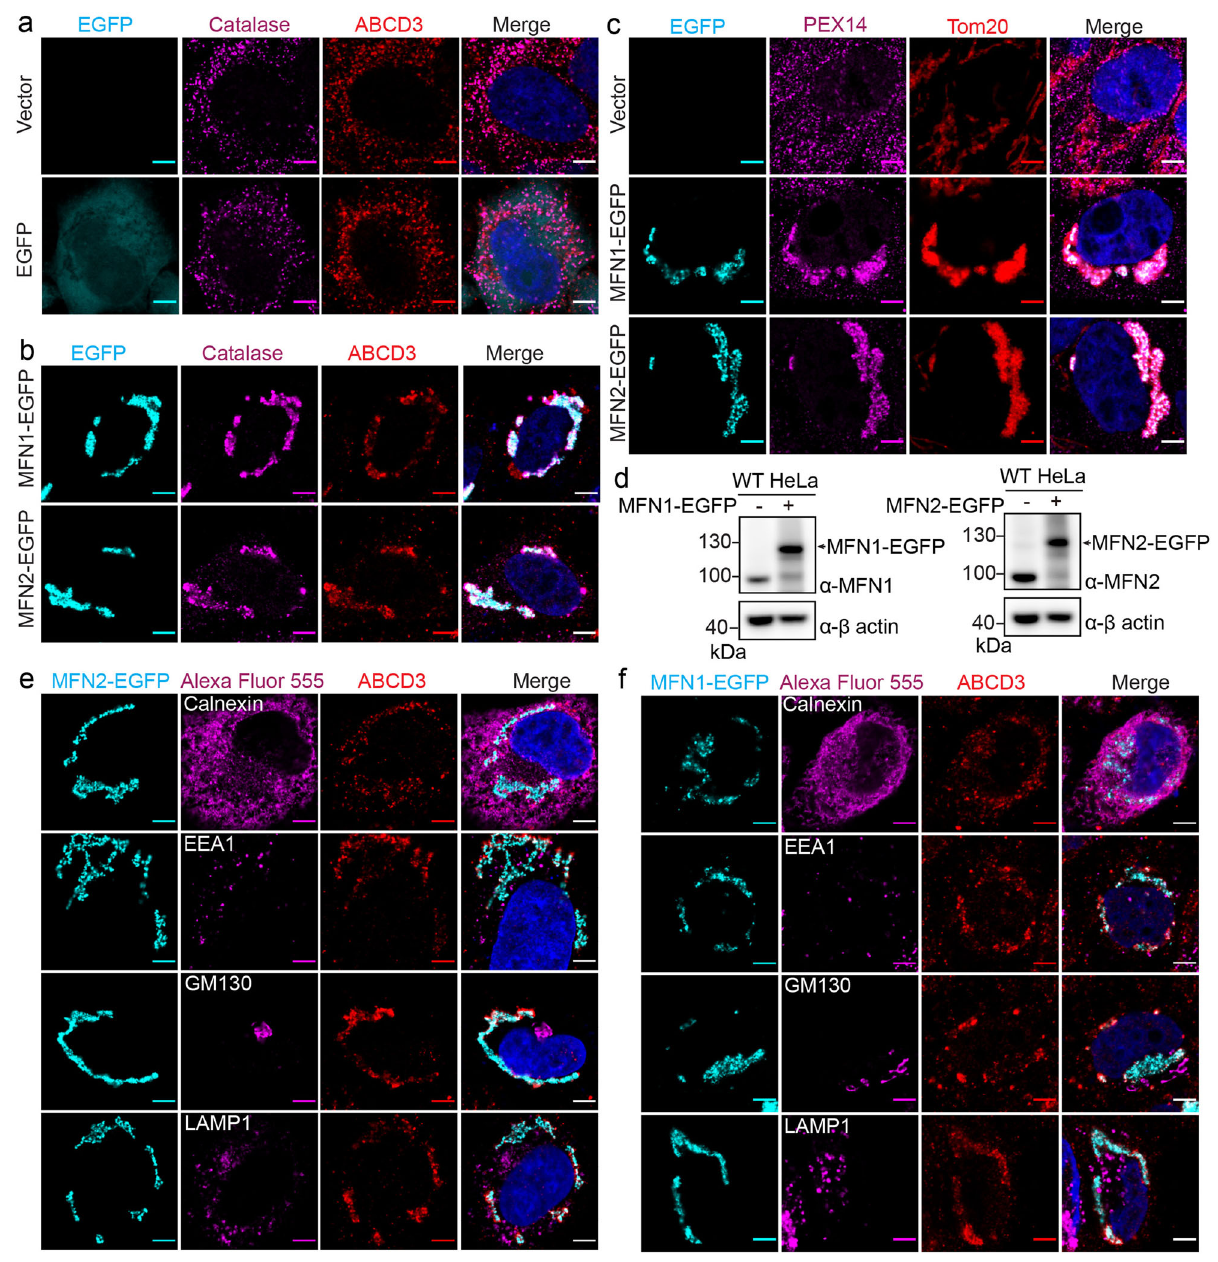
Fig. 3 Exogenous expression of MFN induces peroxisome/mitochondrion clustering. Immuno fl uorescence images of overexpressed MFN-EGFP. HeLa cells were transfected with free EGFP ( a ) or EGFP fused MFN ( b ) plasmids for 36 h. Peroxisomal matrix protein catalase (Alexa Fluor 555) and peroxisomal membrane protein ABCD3 (Alexa Fluor 647) were immune-stained. Scale bars, 5 μ m. c Peroxisomal membrane protein PEX14 (Alexa Fluor 555) and outer mitochondrial membrane protein Tom20 (Alexa Fluor 647) were immunostained with or without exogenously expressed MFNs. Scale bars, 5 μ m. d Immuno-blots of overexpressed MFN1-EGFP and MFN2-EGFP. 1.5 µ g plasmids were transfected into HeLa cells in one well in a six-well cell culture plate for 36 h and immunoblotted with indicated antibodies. e Immuno fl uorescence images of overexpressed MFN2-EGFP and other organelle markers. HeLa cells were transfected with MFN2-EGFP and immunostained for peroxisomal membrane protein ABCD3 (Alexa Fluor 647) and other organelle markers (Alexa Fluor 555): calnexin (endoplasmic reticulum), EEA1 (early endosome), GM130 (Golgi), and LAMP1 (lysosome). Scale bars, 5 μ m. f Immuno fl uorescence images of overexpressed MFN1-EGFP and other organelle markers stained the same as in ( c